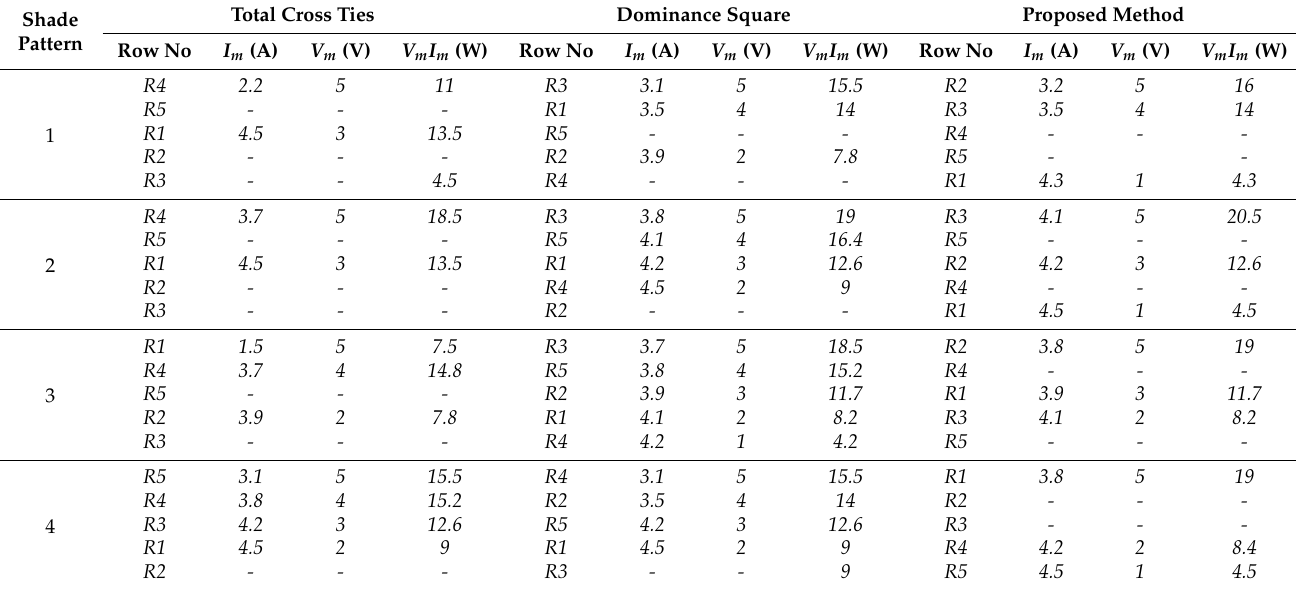
Table 1. Theoretical row current calculation for shade patterns 1–4.